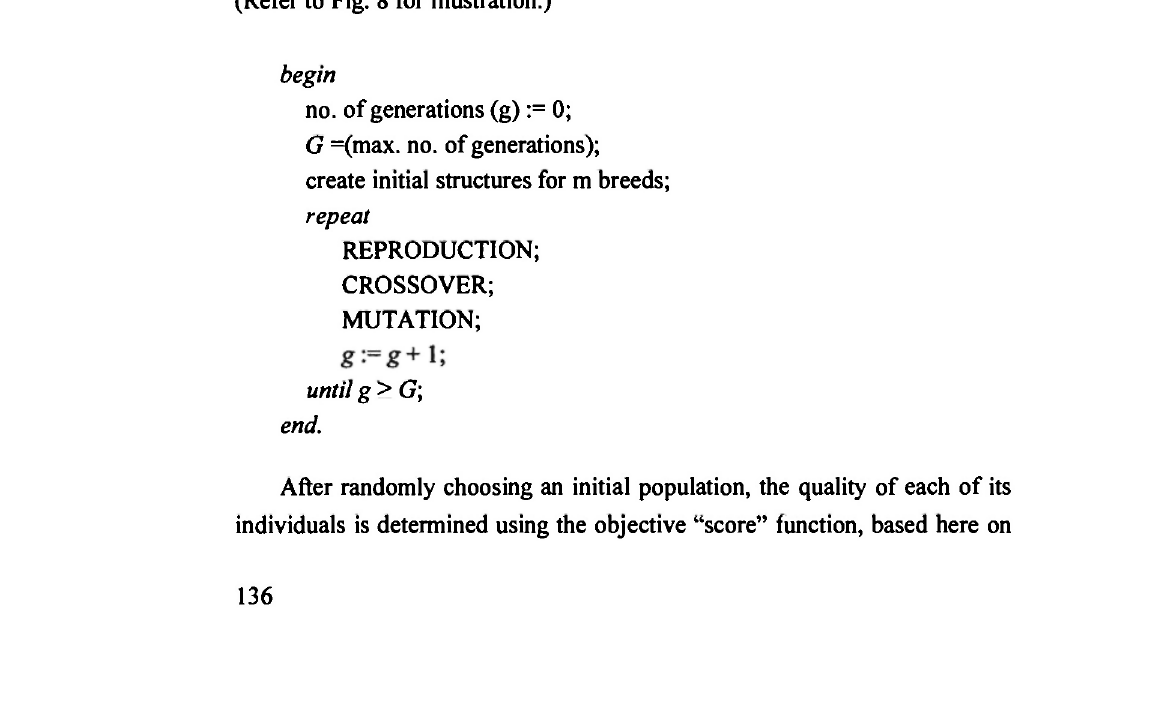
The basic structure of the genetic adaptation algorithm is shown below. (Refer to Fig. 8 for